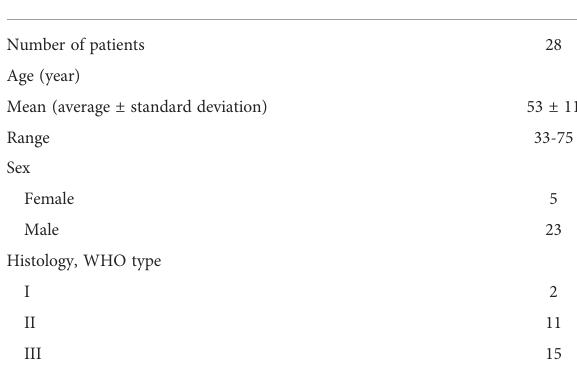
TABLE 1 Summary of patient basic